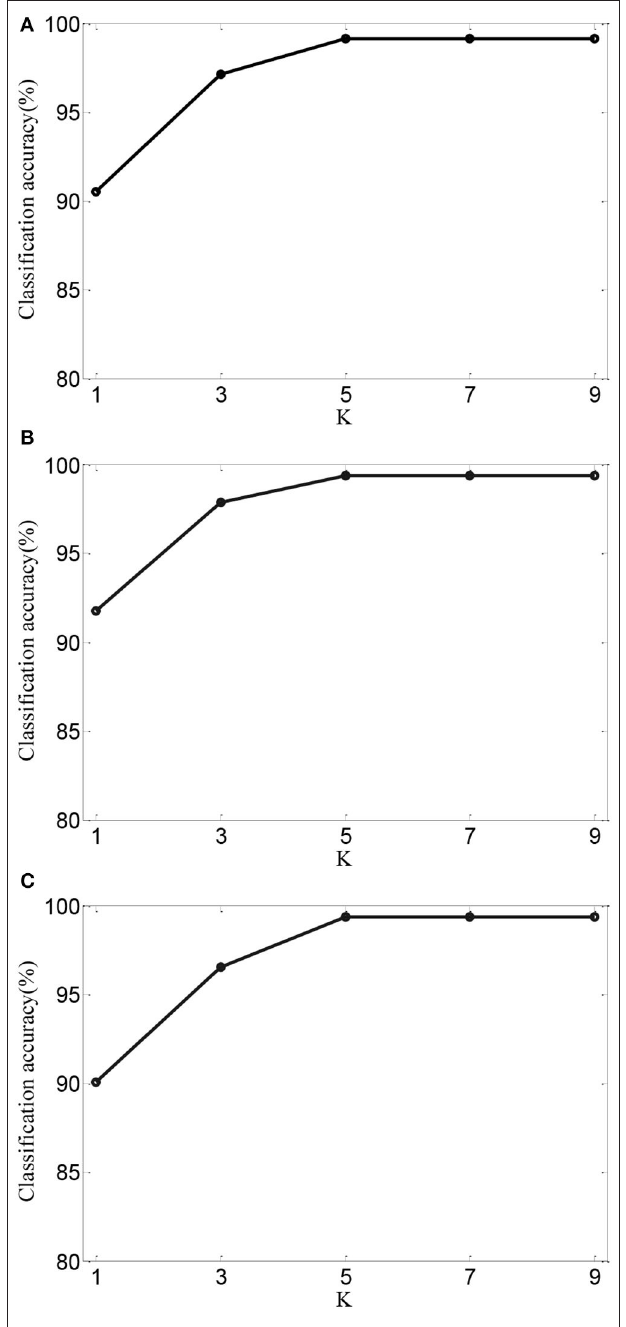
FIGURE 4 | Classification accuracy of AMDML-KNN with different values of k 1 for (A) Task 1, (B) Task 4, and (C) Task 8.